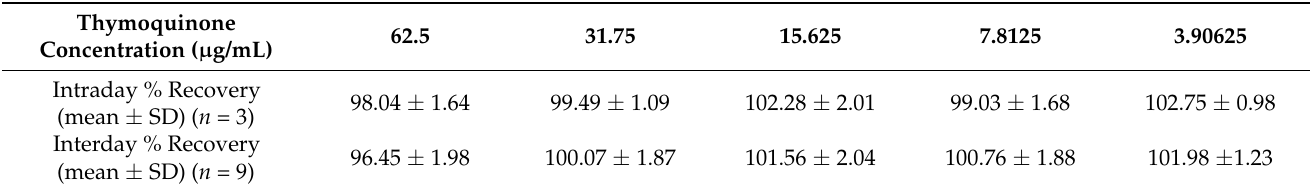
Table 4. Precision and reproducibility of TQ analysis and HPLC method for assessing inter- and intraday reproducibility.